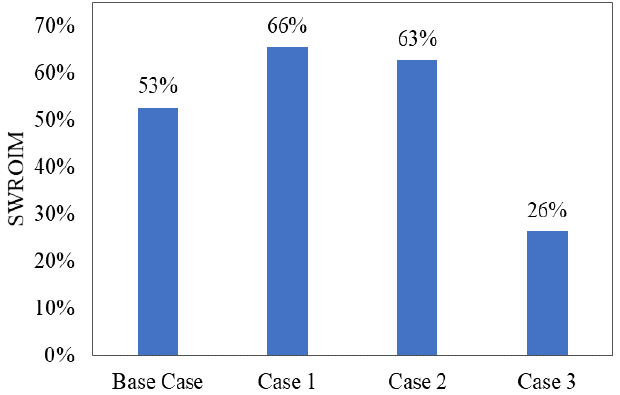
Figure 7. SWROIM sensitivity analysis.